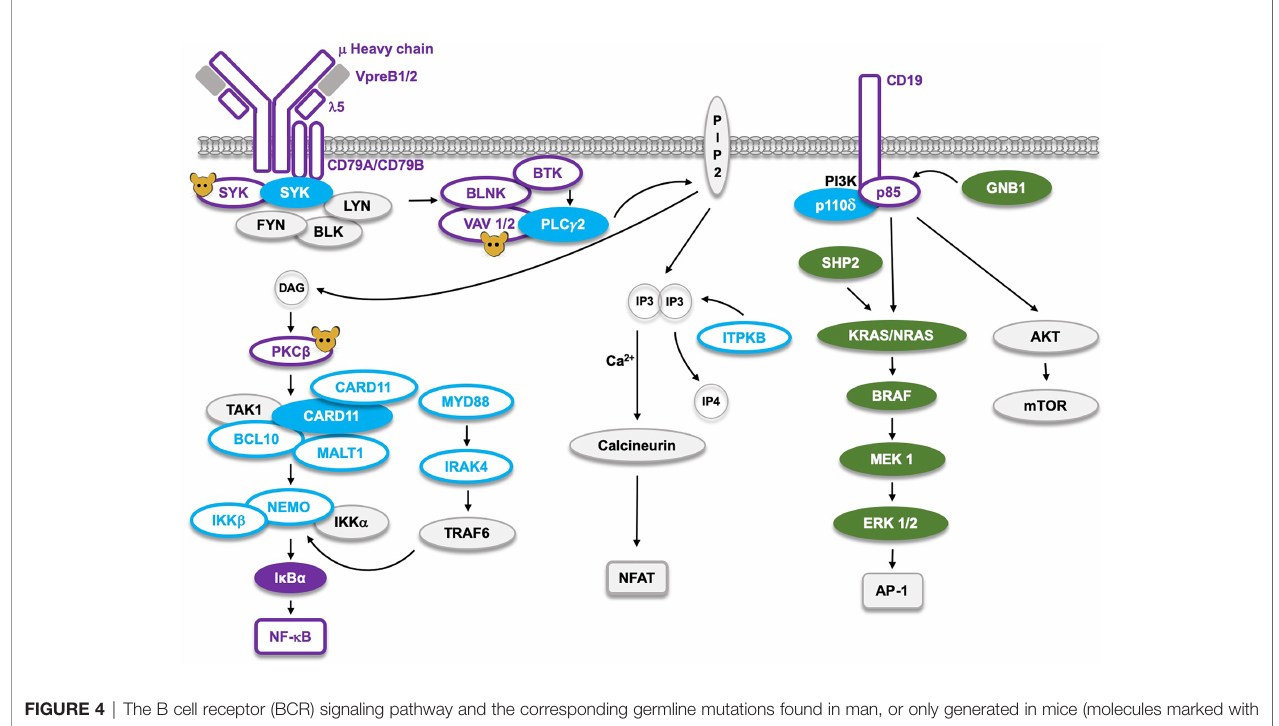
FIGURE 4 | The B cell receptor (BCR) signaling pathway and the corresponding germline mutations found in man, or only generated in mice (molecules marked with ). Proteins marked as represent Loss-of-Function (LoF) mutations with defects limited to B cells , whereas the LoF mutations marked as cause defects not limited to B cells. The corresponding fi lled symbols mark Gain-of-Function (GoF). CARD11 and SYK, which are the only proteins affected by either GoF or LoF, appear as two molecules. LoF mutations in the NF- k B pathway cause B cell defects, whereas those affecting AP-1 signaling result in GoF RASopathies marked